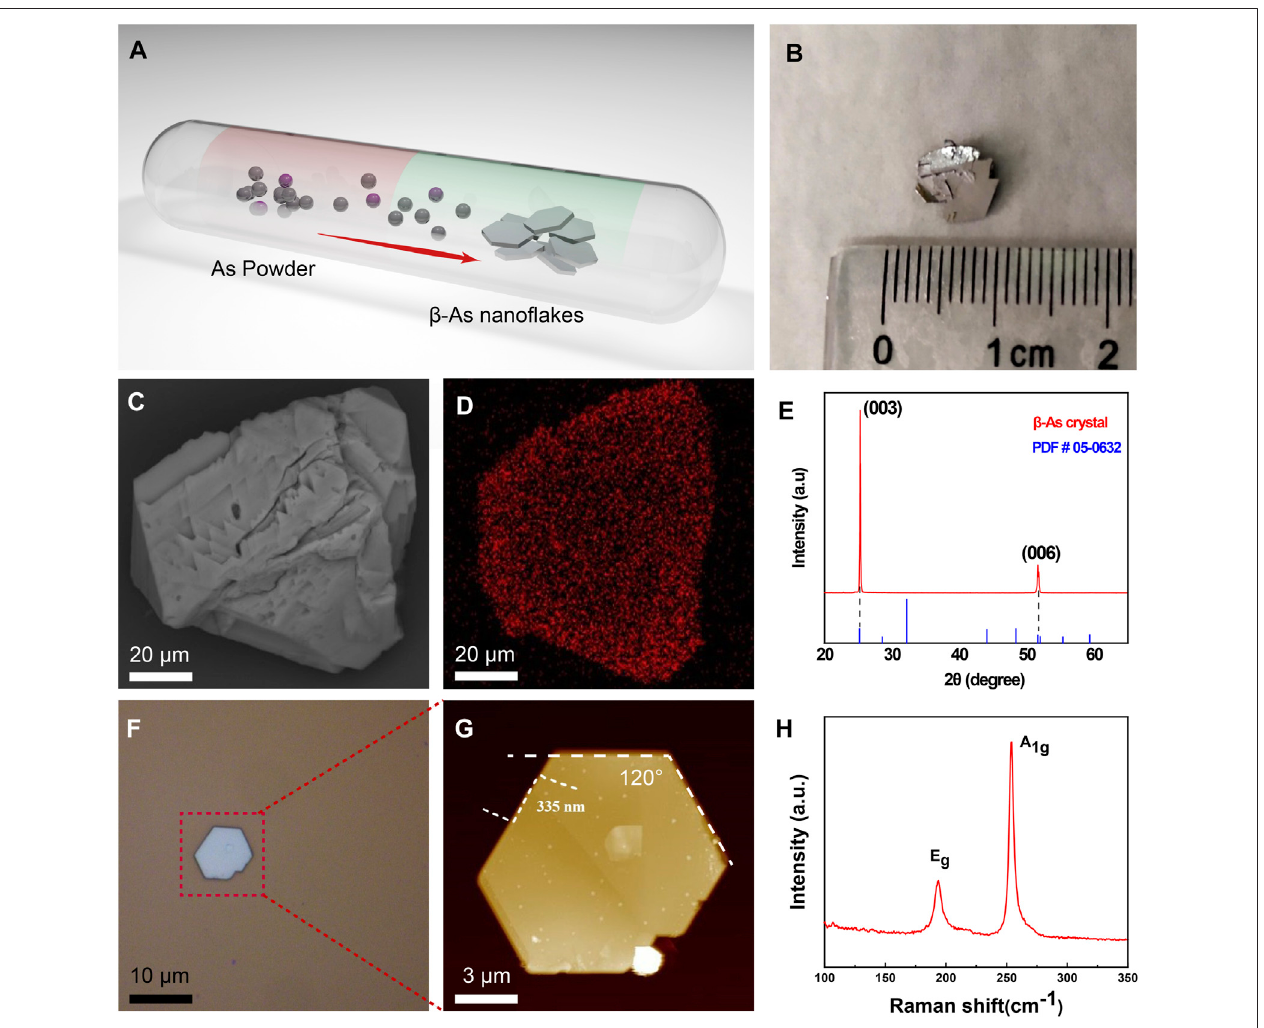
FIGURE 1 | β -phase arsenic crystals synthesis and characteristics. (A) Schematic illustration of the growth process of β -As crystals via the CVT method. (B) The optical image of β -As single crystal besides a ruler. (C) SEM and (D) the energy dispersive X-ray (EDX) mapping of β -As crystal. (D) The optical image of the typical exfoliatednano fl akeaftertransferredontheSiO2/Sisubstrate. (E) X-raydiffraction(XRD)spectrumof β -Ascrystal. (F) A β -Asnano fl aketransferredonSiO2/Sisubstrate. (G) AFM image and the corresponding height of β -As nano fl ake. (H) Raman spectrum of the exfoliated β -As fl ake obtained with a 532 nm laser at about 300 K.